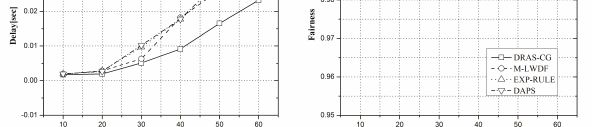
Figure 8: Delay of VoIP Ser- vice